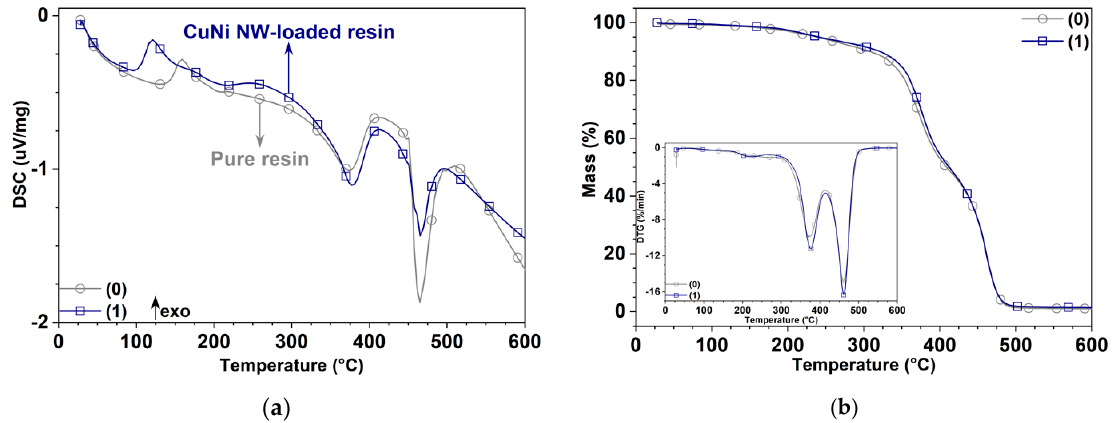
Figure 7. Thermal analysis of the pure (0) and CuNi NW-loaded (1) substrates by ( a ) DSC, ( b ) TGA, and DTGA (insert) as a function of the temperature. Table 2. Values determined from the DMA, DSC, and TGA analysis.